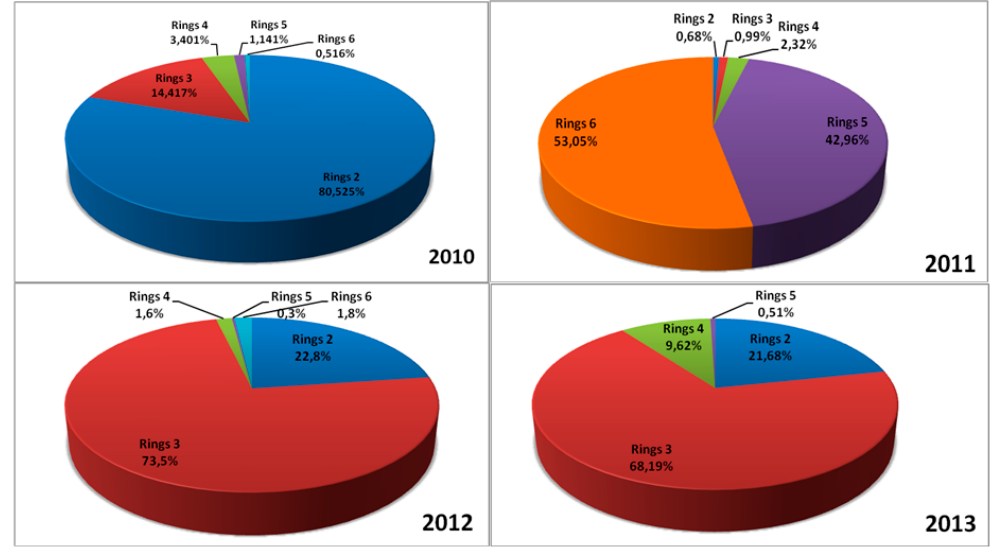
Figure 6. Percentage share of individual compounds with 2, 3, 4, 5 and 6 rings in total number of PAHs in the total number of PAHs ( ∑ 16PAHs) detected in the surface water samples collected in the Fuglebekken catchment over the years 2010–2013.